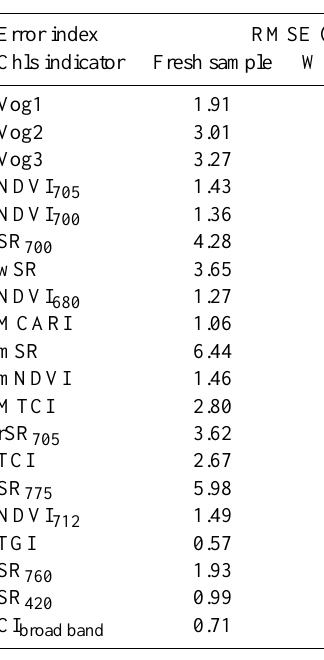
Table 5. Foliar Chls prediction accuracy of the previously developed spectral indices.